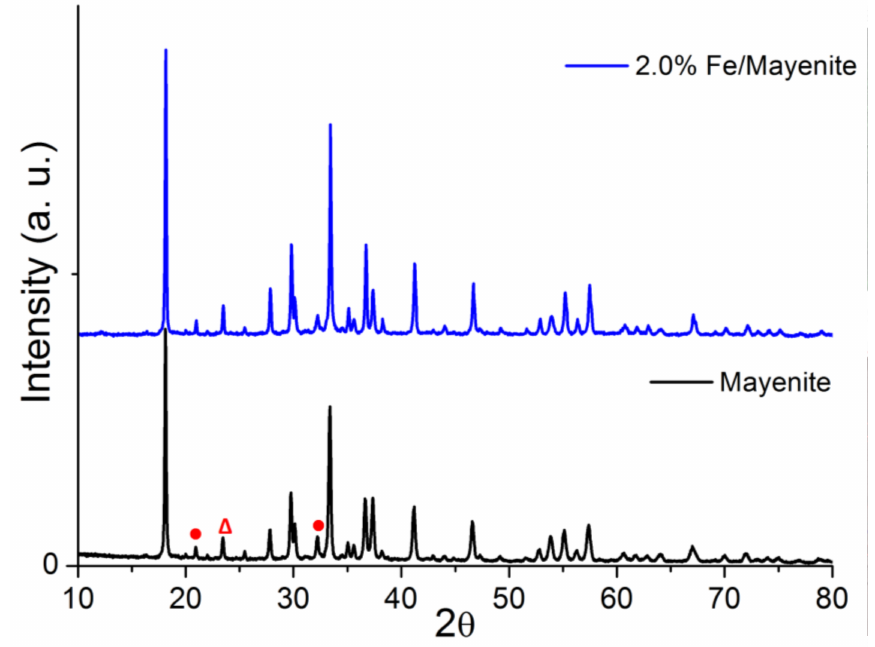
Figure 1. XRD patterns of mayenite (black) and 2.0% Fe / mayenite (blue).